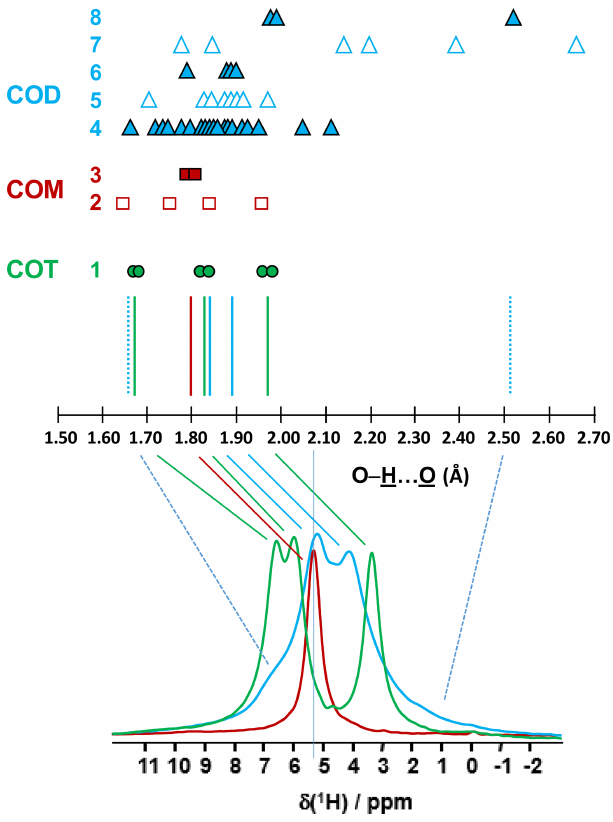
Figure 2. Prediction of the relative positions of δ iso ( 1 H) for COM (red), COD (blue) and COT (green) as a function of the shortest O − H ... O distances (in Ångström; hereafter Å). The general rules are as follows: (i) for a given O − H ... O distance, a δ iso ( 1 H) is associated (vertical colored solid lines), and (ii) if local dynamics are present, averaged O − H ... O distances are first calculated. All distances are derived from optimized geometries at the DFT level (Table A1 and Sect. 6). The effect of eventual local dynamics in the case of the “less rigid” structure is taken into account. For line 1, the structure of COT is considered as being “rigid” (plain green circles). On the basis of the shortest O − H ... O distance, the six inequivalent protons can be associated in three groups. To each group, a single average δ iso ( 1 H) is assigned. A total of three lines for COT is predicted (represented by the three vertical green solid lines). For line 2, the structure of COM is considered as being less rigid (open squares), while for line 3 the corresponding averaged distances are represented by plain squares. A single average δ iso ( 1 H) is associated as the averaged distances are very close. A total of one line for COM is predicted. The COD case is shown in lines 4 to 8, where COD exhibits both rigid (plain triangles; line 4) and less rigid water molecules (open triangles in line 5 for the four structural water molecules and in line 7 for the three zeolitic water molecules). For line 6, the corresponding averaged distances for the structural water molecules are represented by plain triangles, and for line 8, the corresponding averaged distances for the zeolitic water molecules are represented by plain triangles. A continuum of δ iso ( 1 H) is predicted for COD. The vertical blue dashed lines correspond to the expected limits of δ iso ( 1 H). The two vertical solid blue lines correspond to local maxima, adding lines 4, 6 and 8. At the bottom, the superposition of the 1 H DUMBO MAS NMR spectra for COM (red), COD (blue) and COT (green; see Fig. 1a) is shown. The solid and dashed lines connect the experimental data and the predicted δ iso ( 1